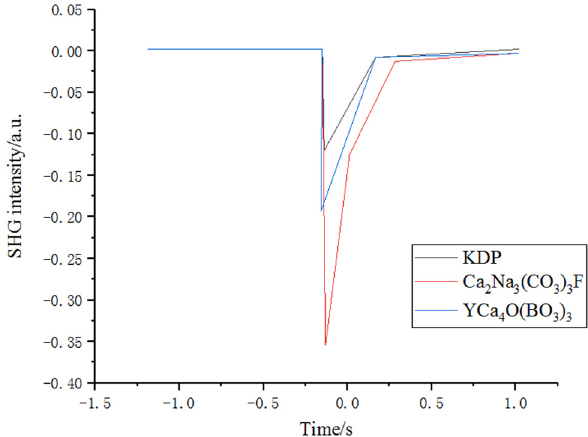
Figure 1: Comparison of optical properties of Ca 2 Na 3 ( CO 3 ) 3 F and YCa 4 O ( BO 3 ) 3